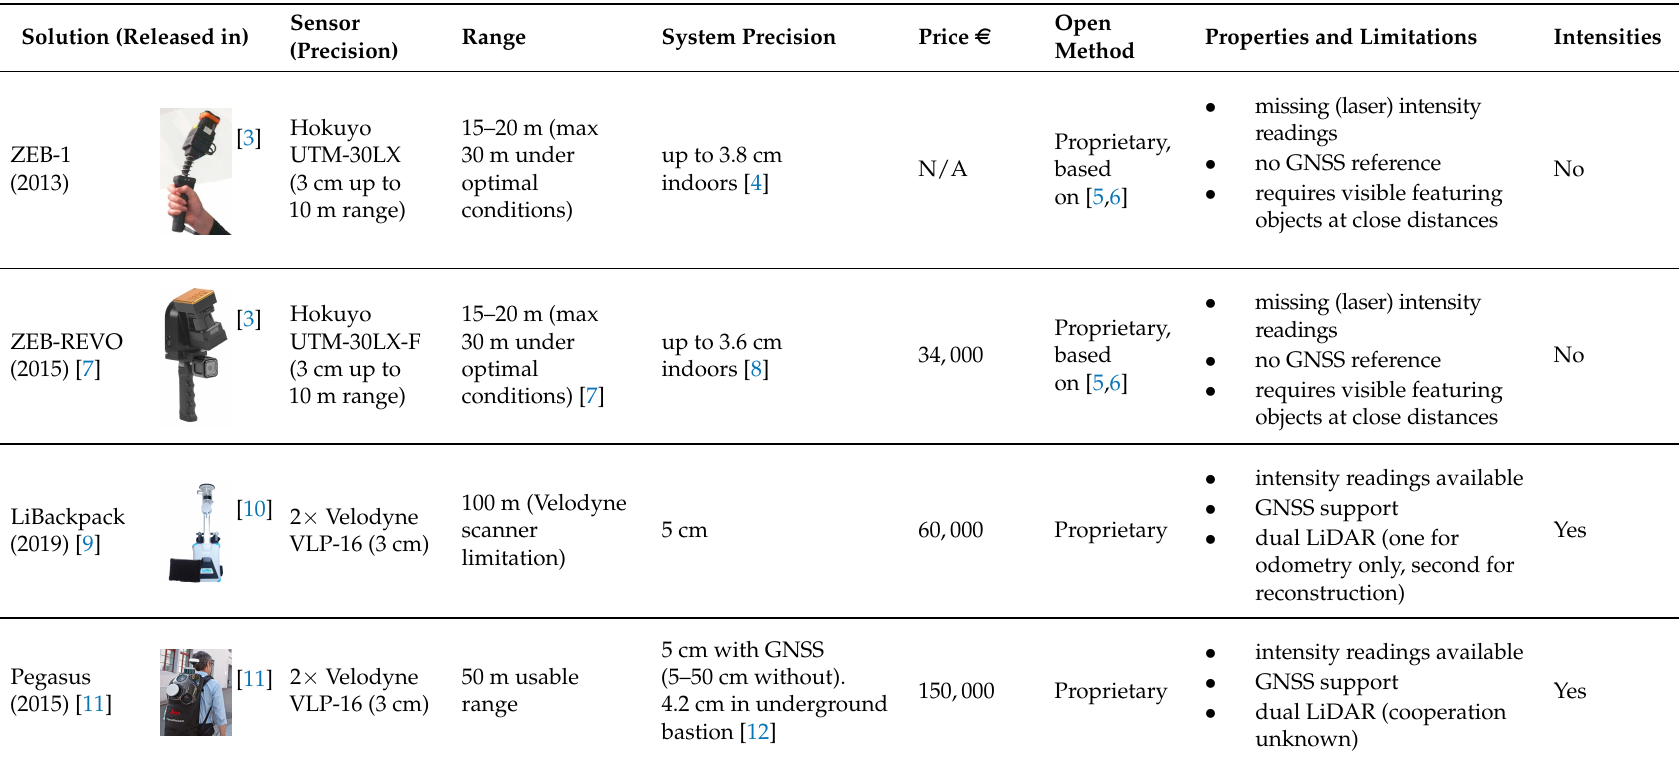
Table 1. Overview of related LiDAR mobile mapping